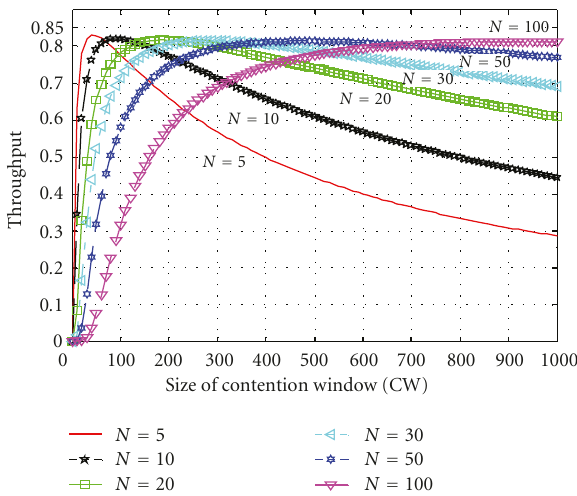
Figure 3: Relation between throughput and contention